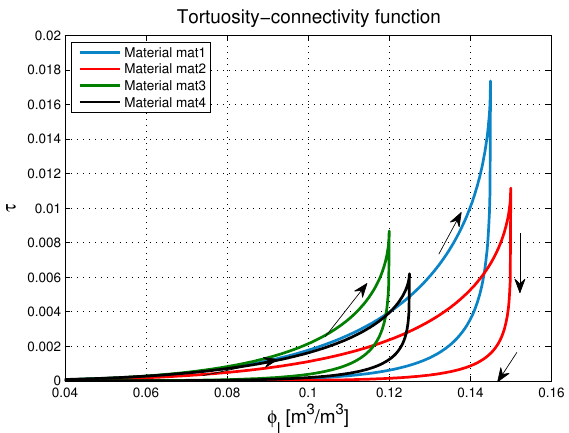
Figure 4. The tortuosity as a function of the pore water